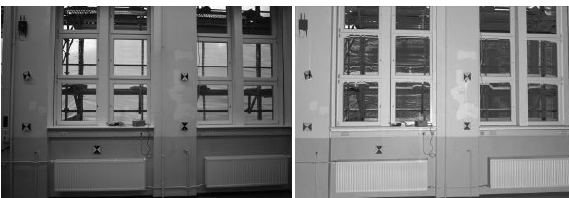
Figure 4. Rectified image (left), Reflectance image from TLS